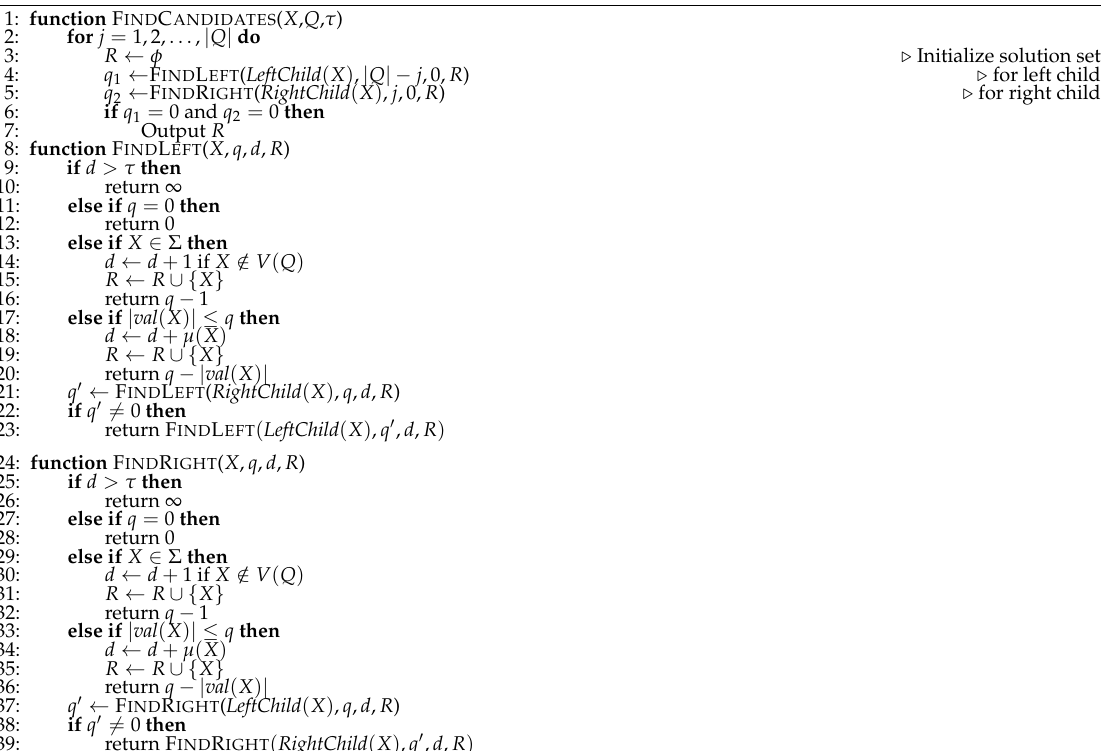
Algorithm 1 to output the candidate R ⊆ V ( S ) for X ∈ V ( S ) , a query pattern Q and a distance threshold τ